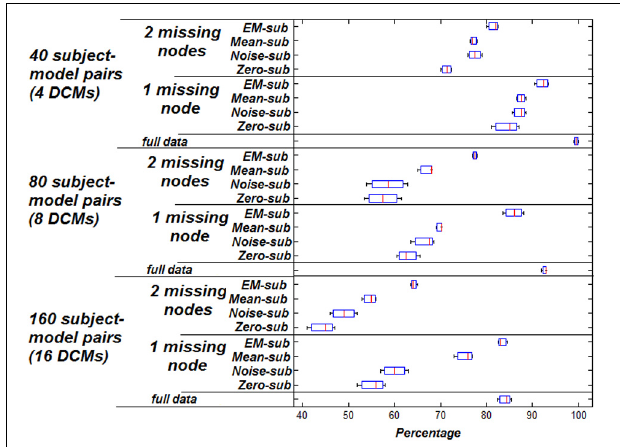
FIGURE 1 | Accuracy of classification based on highest model evidence vs. ground truth. Zero missing nodes (full data) is the baseline for comparison. Box plots show the bootstrap variance of classification